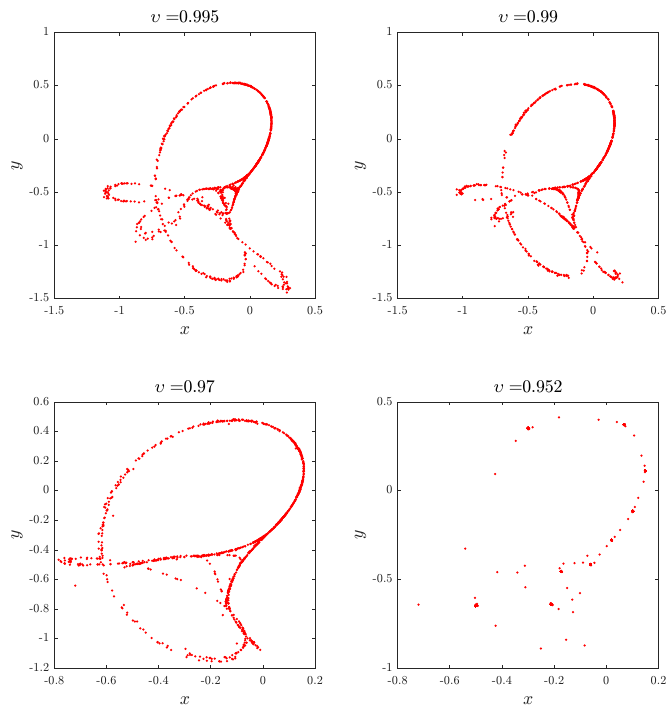
Figure 3. Phase plots of the fractional Tinkerbell map (7) for parameters ( α , β , γ , δ ) = ( 0.9, − 0.6013,2,0.5 ) , initial conditions ( x ( 0 ) , y ( 0 )) = ( − 0.72, − 0.64 ) , and different fractional